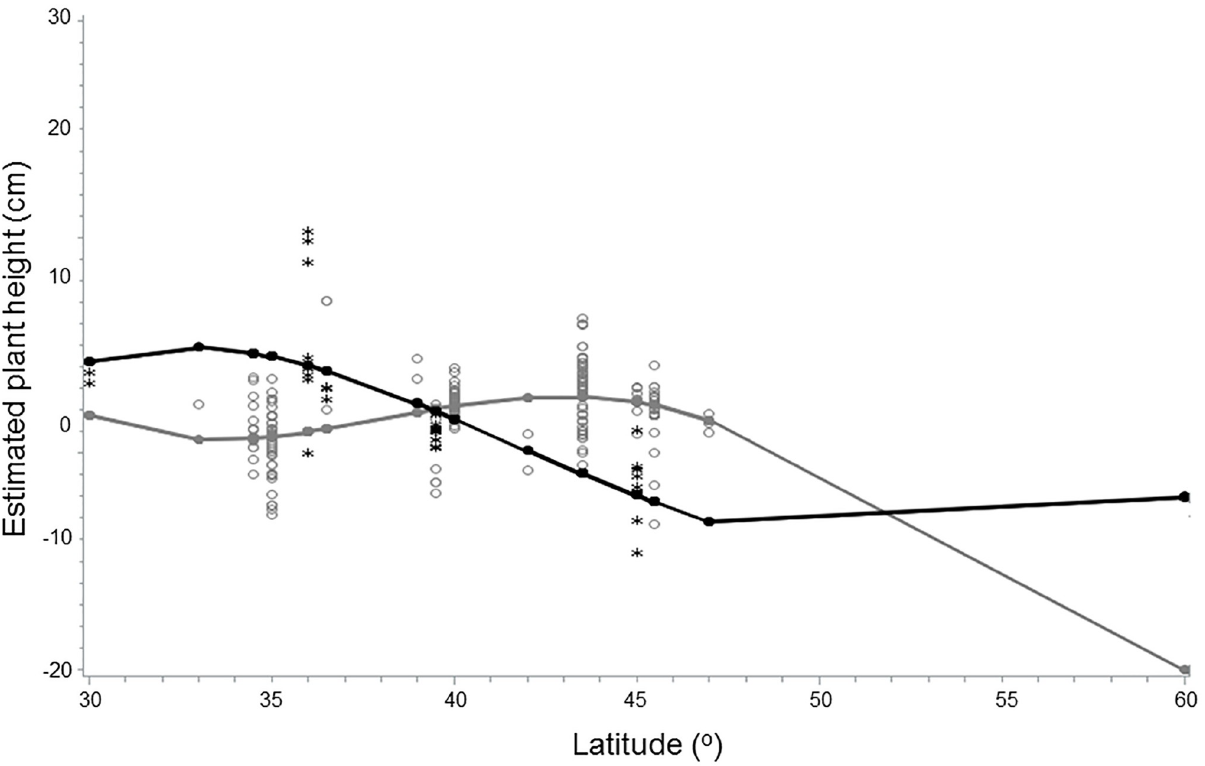
Fig 4. Lythrum salicaria heights (cm) in wetlands of Eurasia vs. North America as measured by volunteers in the Purple Loosestrife Volunteer Network (r 2 = 0.361, p < 0.0001). The interpolated lines represent estimated plant heights for Eurasia and North America (filled black circle/line vs. gray circle/line, respectively). Means of measured heights latitude -1 are represented by stars and triangles (Eurasia and North America, respectively).